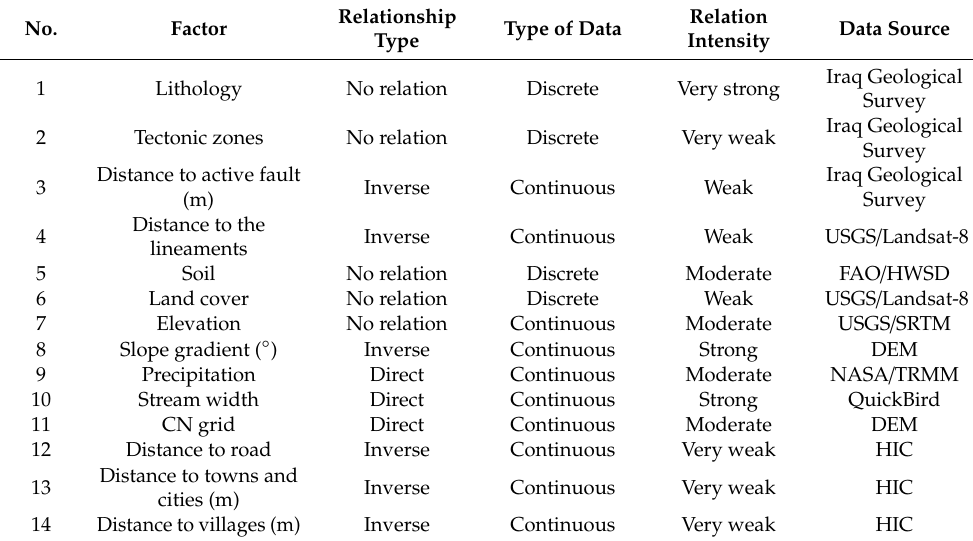
Table 1. Factors’ relations towards the suitable dam site